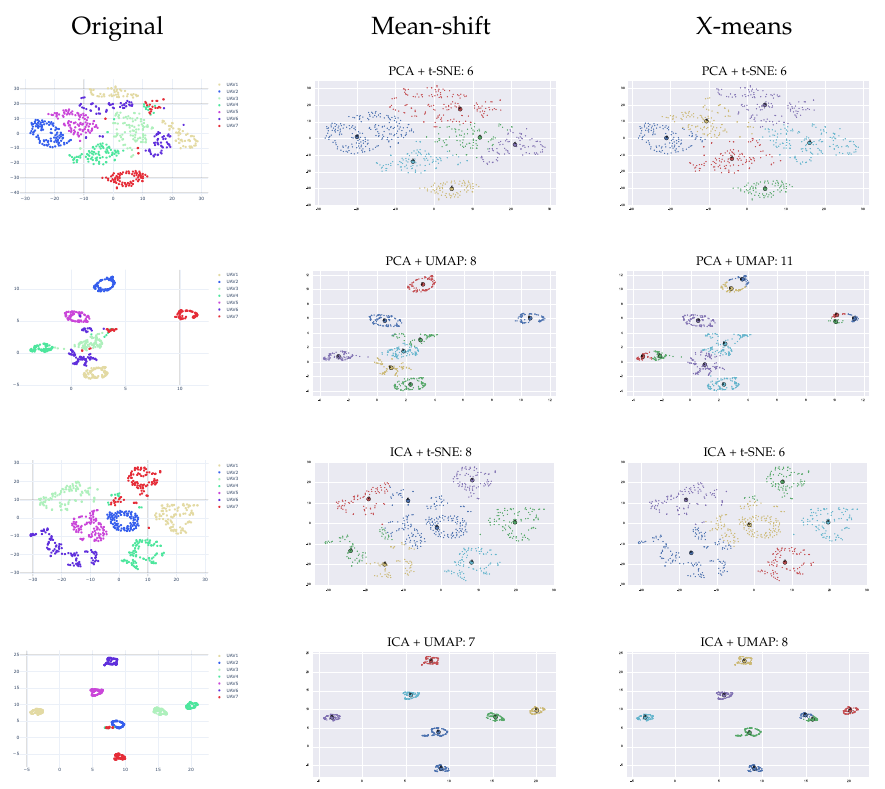
Figure 20. Clustering results using WST and various dimension reduction methods.